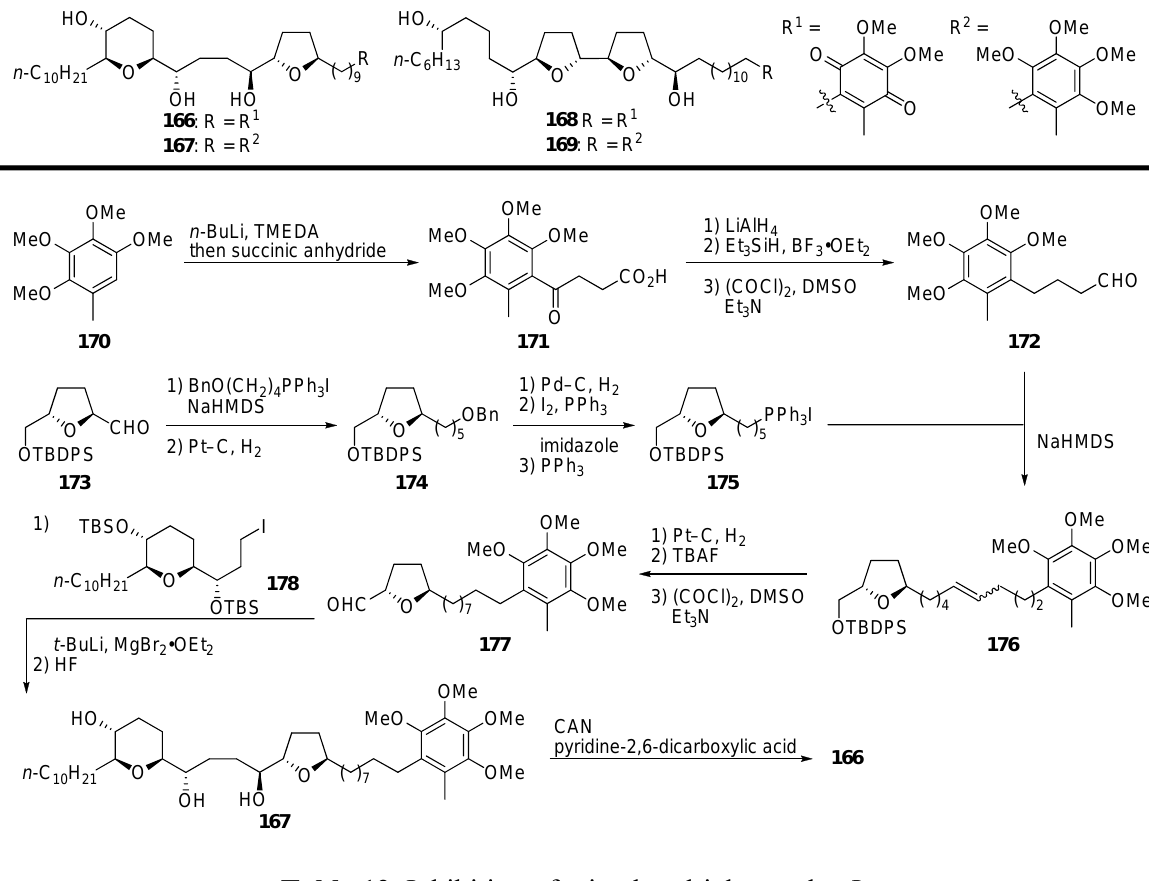
Table 12. Inhibition of mitochondrial complex